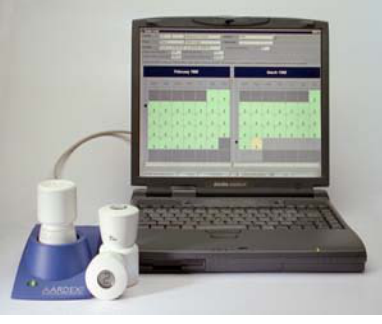
Figure 1. The Medication Electronic Monitoring System (MEMS) (Aardex, Switzerland).